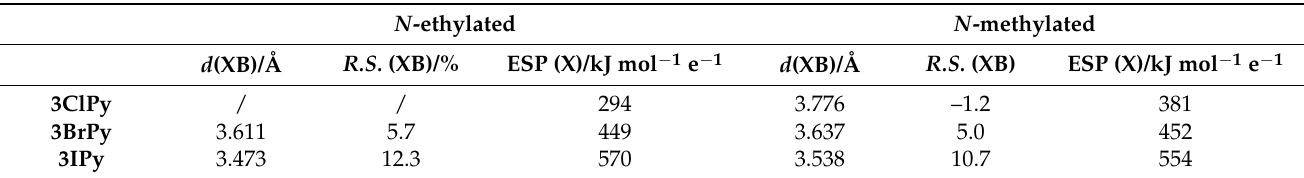
Table 1. An overview of the C − X · · · I − halogen bonds and ESP values in σ -hole area in the N -ethylated and N -methylated 3-halogenopyridines